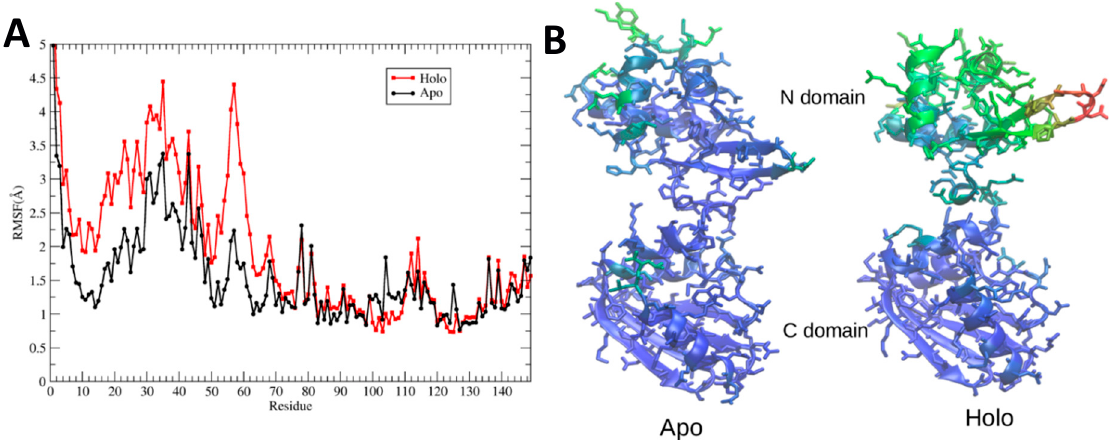
Figure 8. Domain movements upon L-arg binding. ( A ) RMSF was calculated for all non-hydrogen atoms during the final 500 ns of each simulation and averaged over the six monomers of the hexamer. ( B ) RMSF calculated for representative monomer F was converted to crystallographic B-factors (see Methods) and colored from lowest (blue) to highest (red).